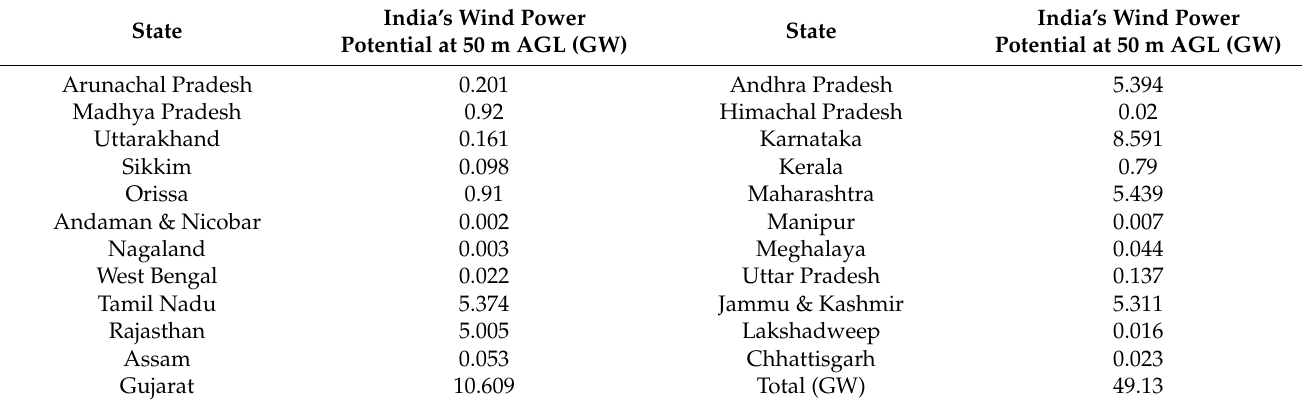
Table 12. India’s wind power potential at 50 m above ground level (gigawatts). Source: NIWE, India [58].